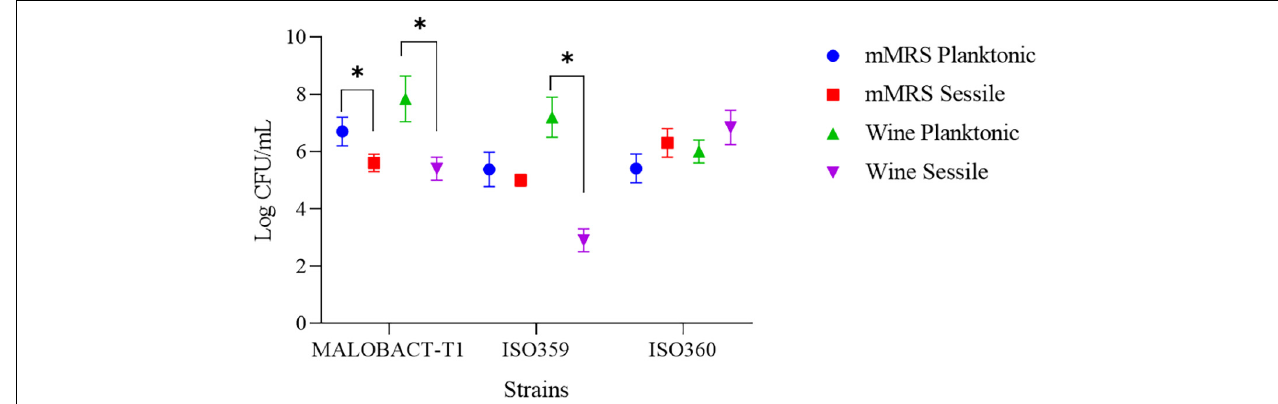
FIGURE 1 | Planktonic and sessile cells determined by plate count in mMRS and organic wine. Results are represented as means ± SD of three experiments and expressed as log CFU/ml. The symbol ∗ denotes statistical differences ( p < 0.05).